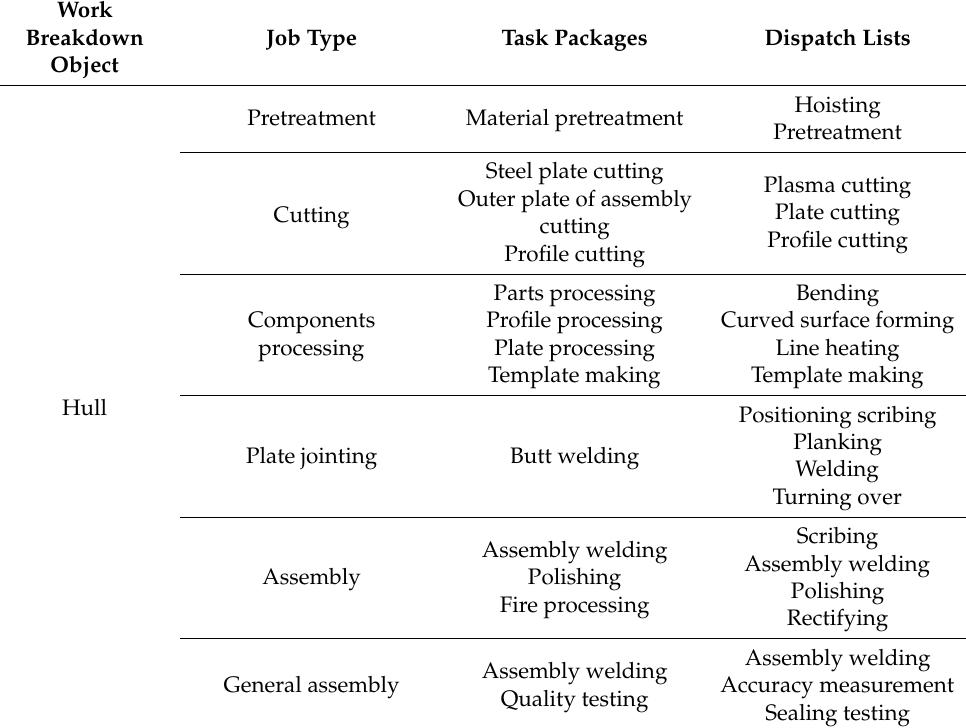
Table 1. Work breakdown for hull section